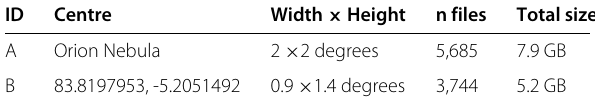
Table 3 Input data sets for the Montage workflow